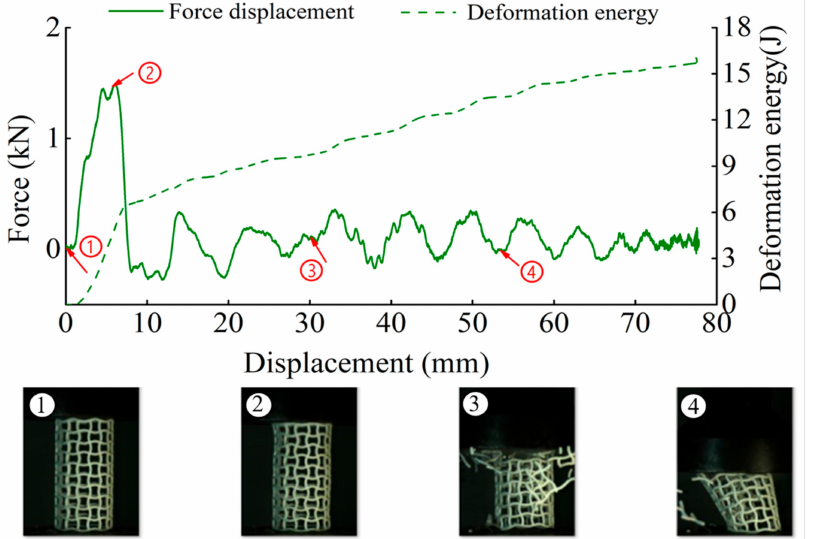
Figure 16. The results of dynamic tests of CCHT1 (1–4 stages of deformation during the dynamic compressive